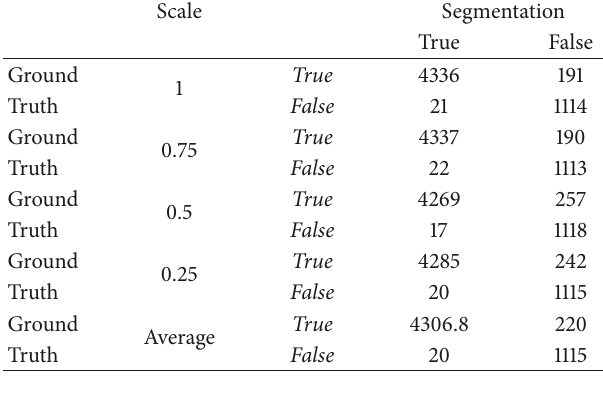
Table 3: Confusion matrix results with other elements. Scale